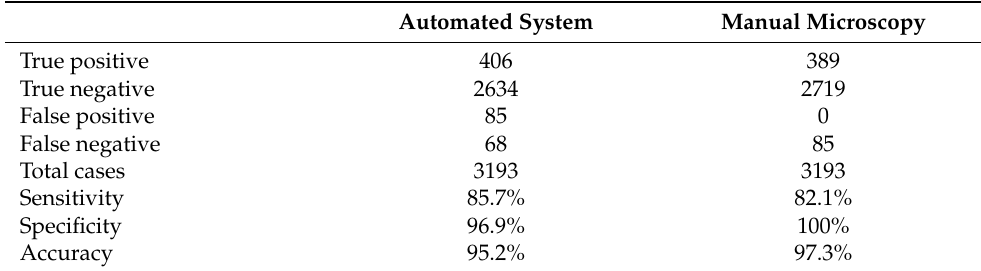
Figure 6. The confusion matrix of automation system with 200 images capture setting after removal of inadequate cases.